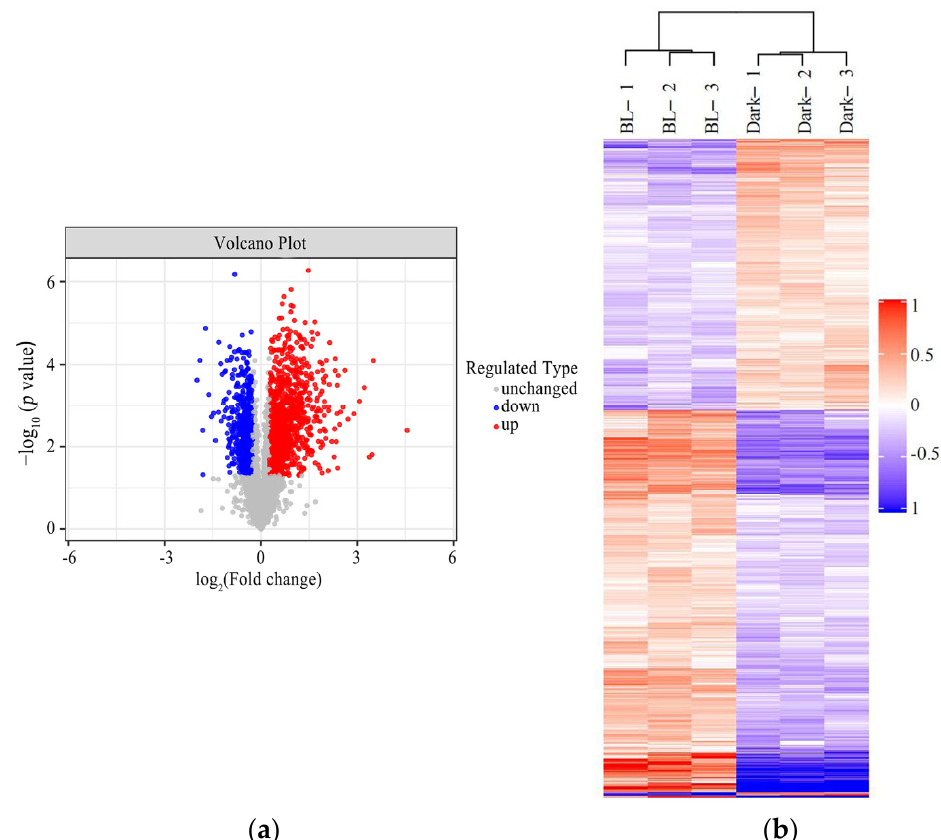
Figure 3. The volcano plot and cluster heatmap of differentially expressed proteins. ( a ) Volcano plot. The abscissa is the fold change (logarithm with base 2), and the ordinate is the significant difference p value (logarithm with base 10). Differentially expressed proteins with red dots represent those that have been significantly upregulated, proteins with blue dots represent those that have been significantly downregulated, and proteins with gray dots represent those that have been not changed. ( b ) Cluster heatmap. Each column represents a group of samples (the abscissa is the sample information), each row represents a significantly differentially expressed protein, and the expression levels of the significantly differentially expressed proteins in different samples were normalized by the log 2 method and displayed in different colors in the heatmap; where red represents significantly upregulated proteins, blue represents significantly downregulated proteins, and gray represents no protein quantification